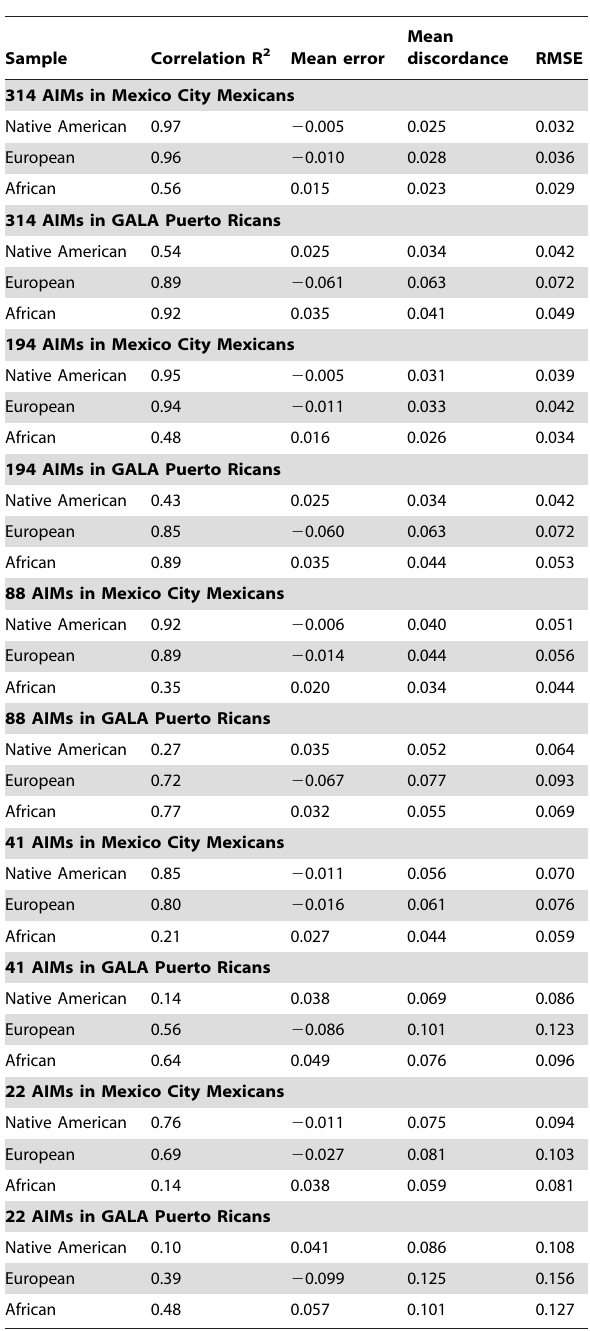
Table 3. Performance of nested subsets of